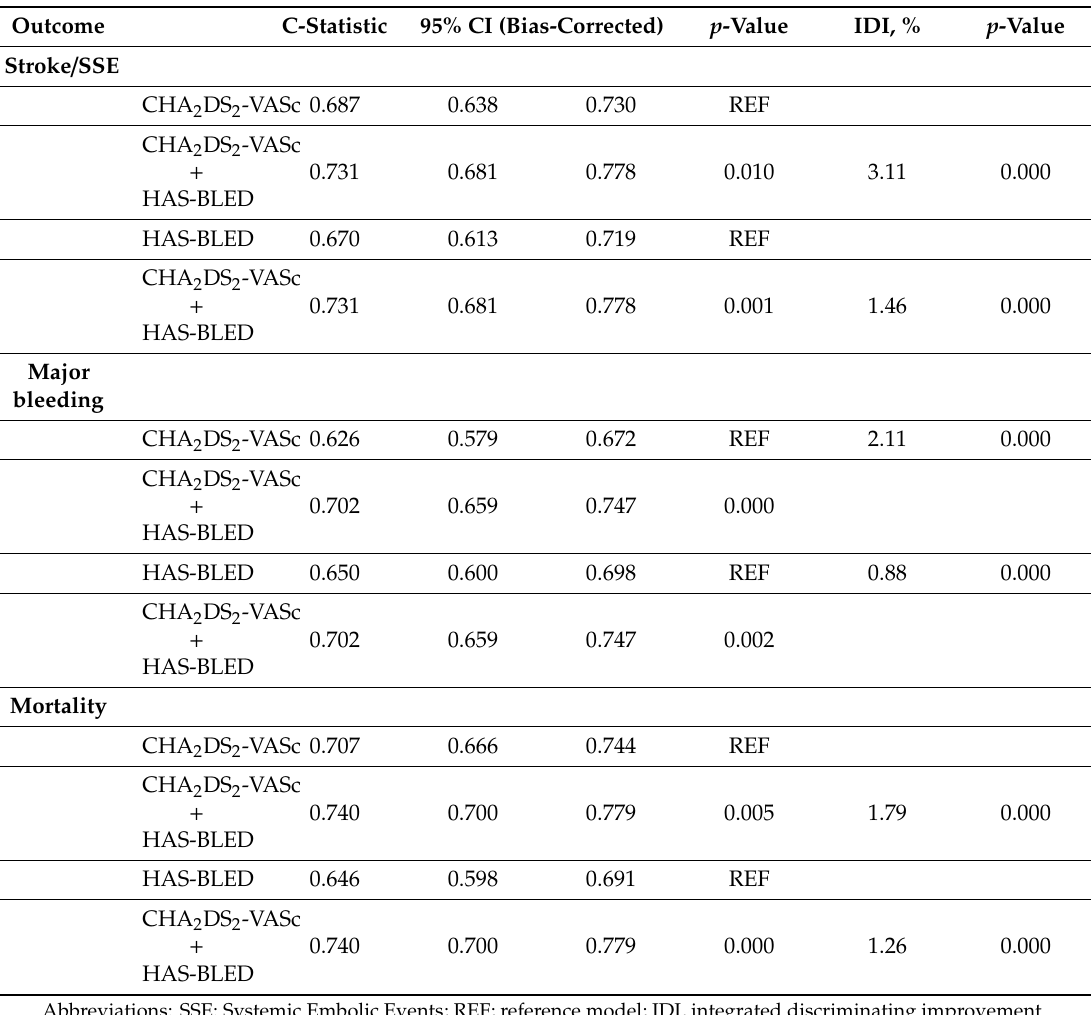
Table 3. Evaluation of the predictive ability of the prediction models for the detection of stroke / SSE, major bleeding and mortality using C-index and integrated discrimination improvement